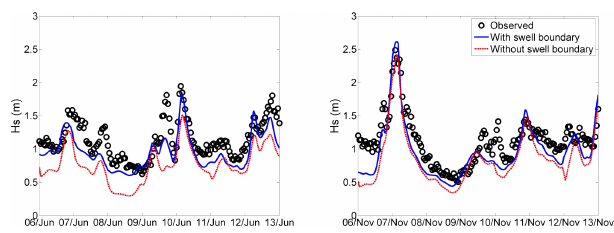
Figure 13. Monthly errors of surge elevation for different HIRLAM for location IJmuiden.